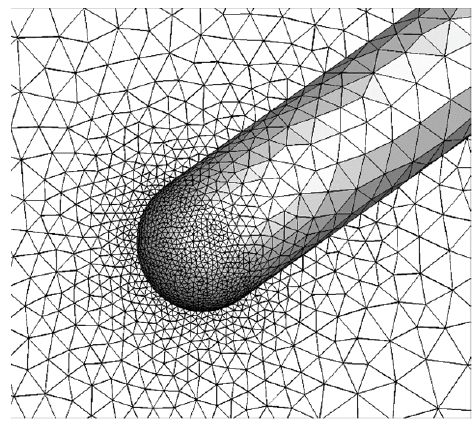
Figure 11. Computational mesh of the hemispherical headform.